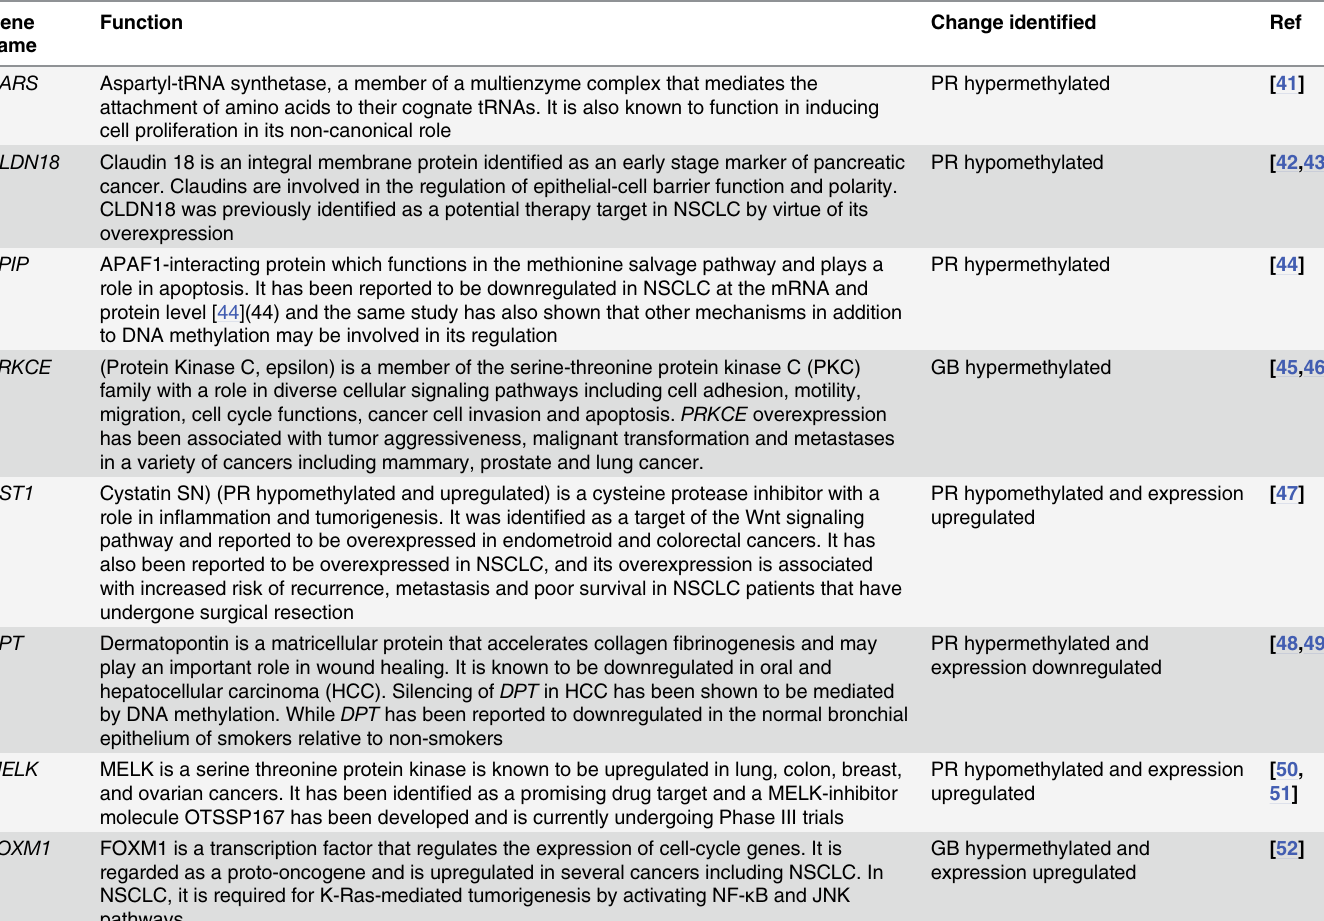
Table 4. Relevance of some novel DM and DM+DE genes in Lung cancer.